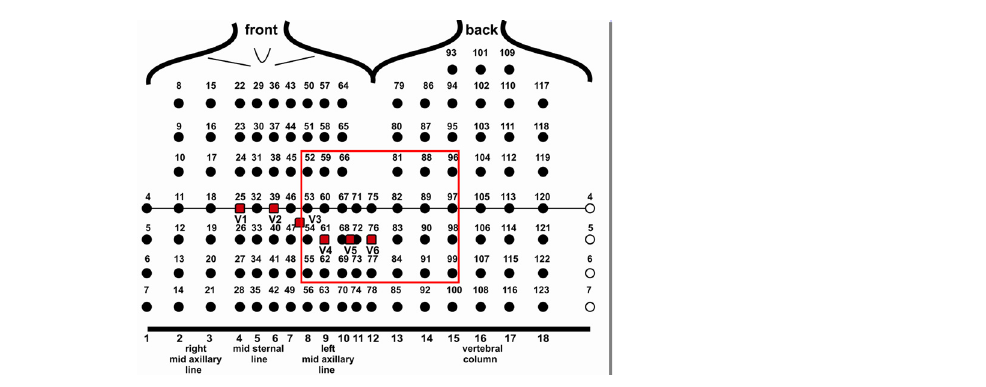
Fig 1. Array of 120 electrodes for the recording of unipolar body surface potentials. Red rectangles indicate the positions of standard chest leads V1 to V6. Red frame indicates the region of interest of Fig 3.